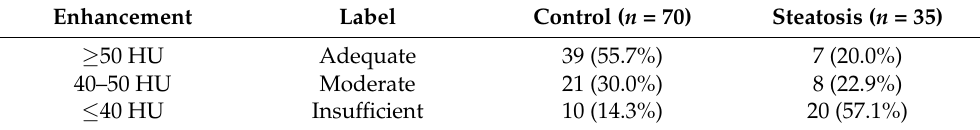
Table 3. Adequacy of liver enhancement during the portal phase based on enhancement values.